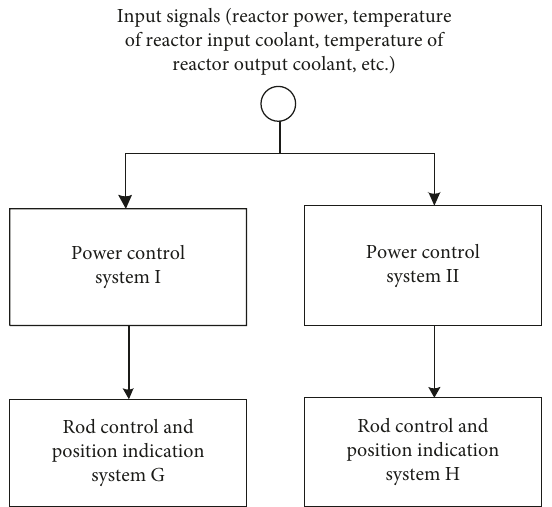
Figure 1: Frame diagram of reactor power control